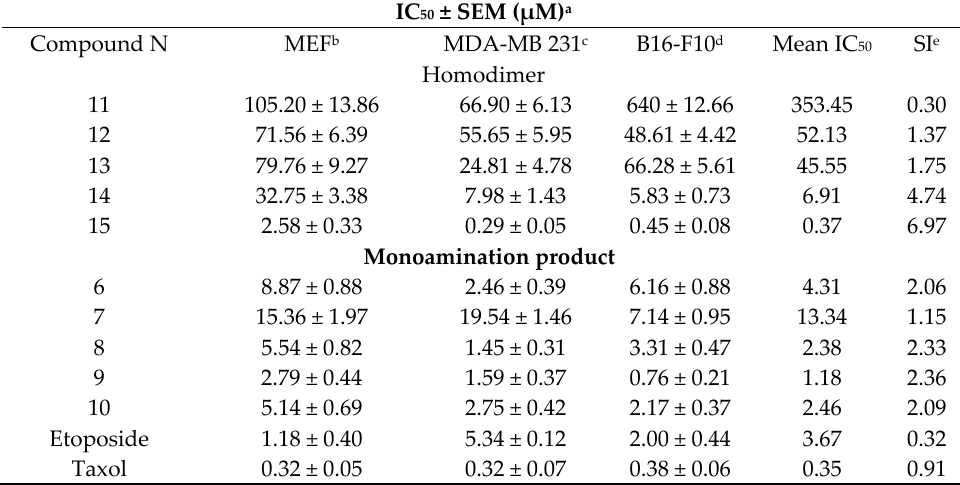
Table 2. IC 50 values, selectivity indexes of homodimers 11–15 and monoamination products 6–10